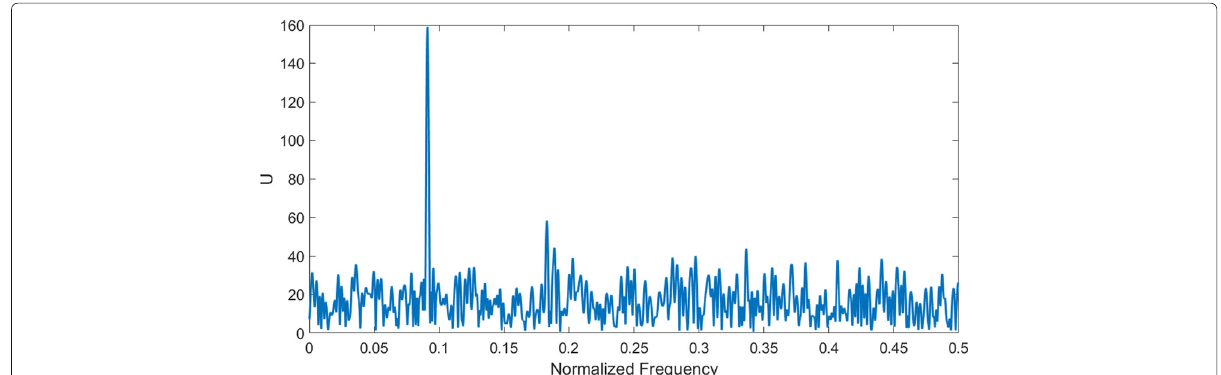
Fig. 3 4096 points DFT of u ( k ) , burst length = 500 symbols, modulation type = BPSK, η = 0.1, SNR = 10 dB. CS is represented as a frequency in